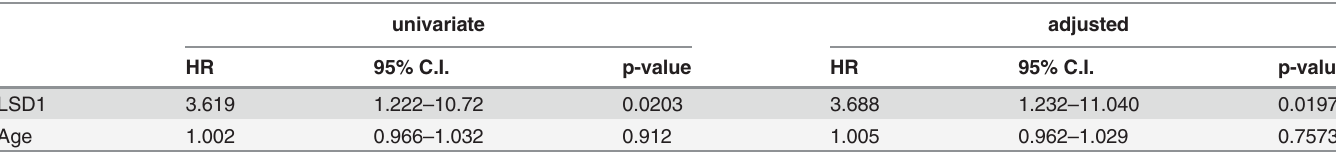
Table 5. Cox proportional hazard model for clinical